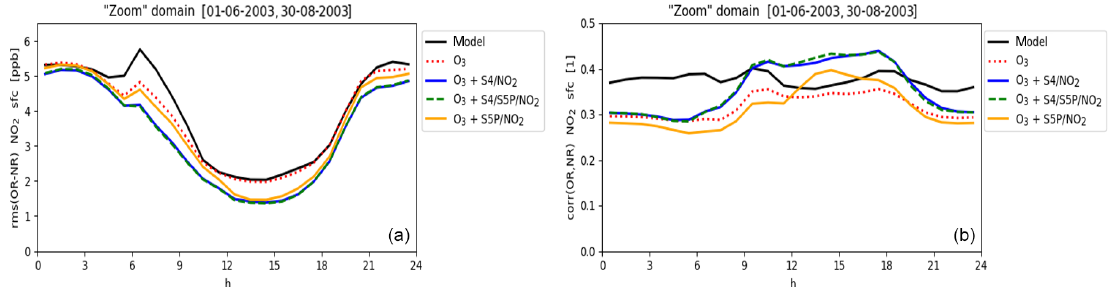
Figure 13. RMSE (a) and correlation (b) with NR surface NO 2 concentrations for the summer period and zoom domain. Prior to (black line) and after assimilation of observations (coloured lines – ground-based O 3 only: dotted red; ground-based O 3 + S4 NO 2 : blue; ground-based O 3 + S5P NO 2 : yellow; and ground-based O 3 + S4 and S5P NO 2 : dashed